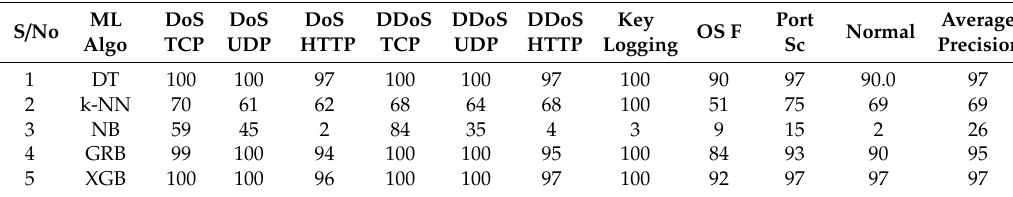
Table 10. Precision summary of the multiclass classification.